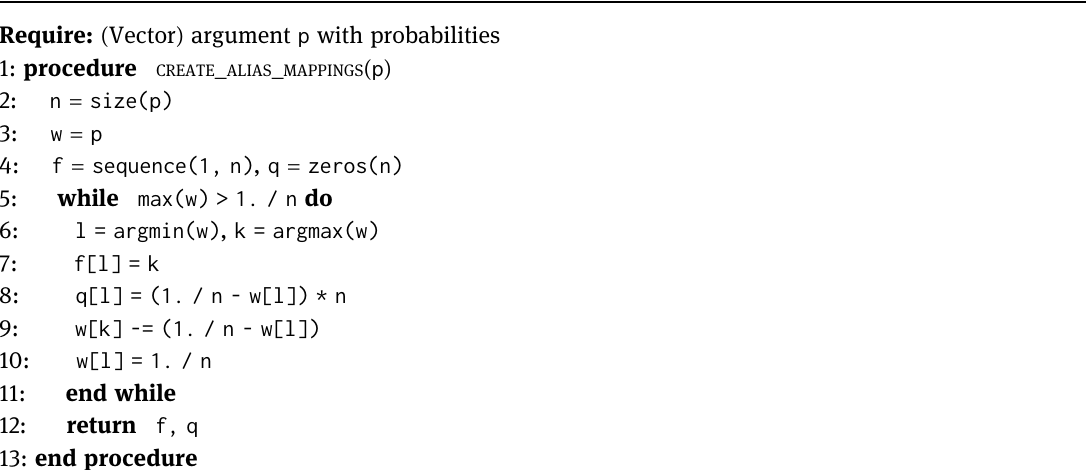
Algorithm 2 . Create mappings f and q for the alias